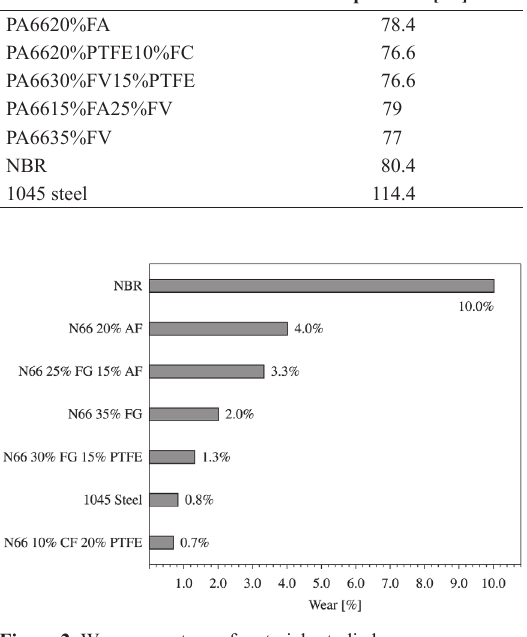
Figure 2. Wear percentage of materials